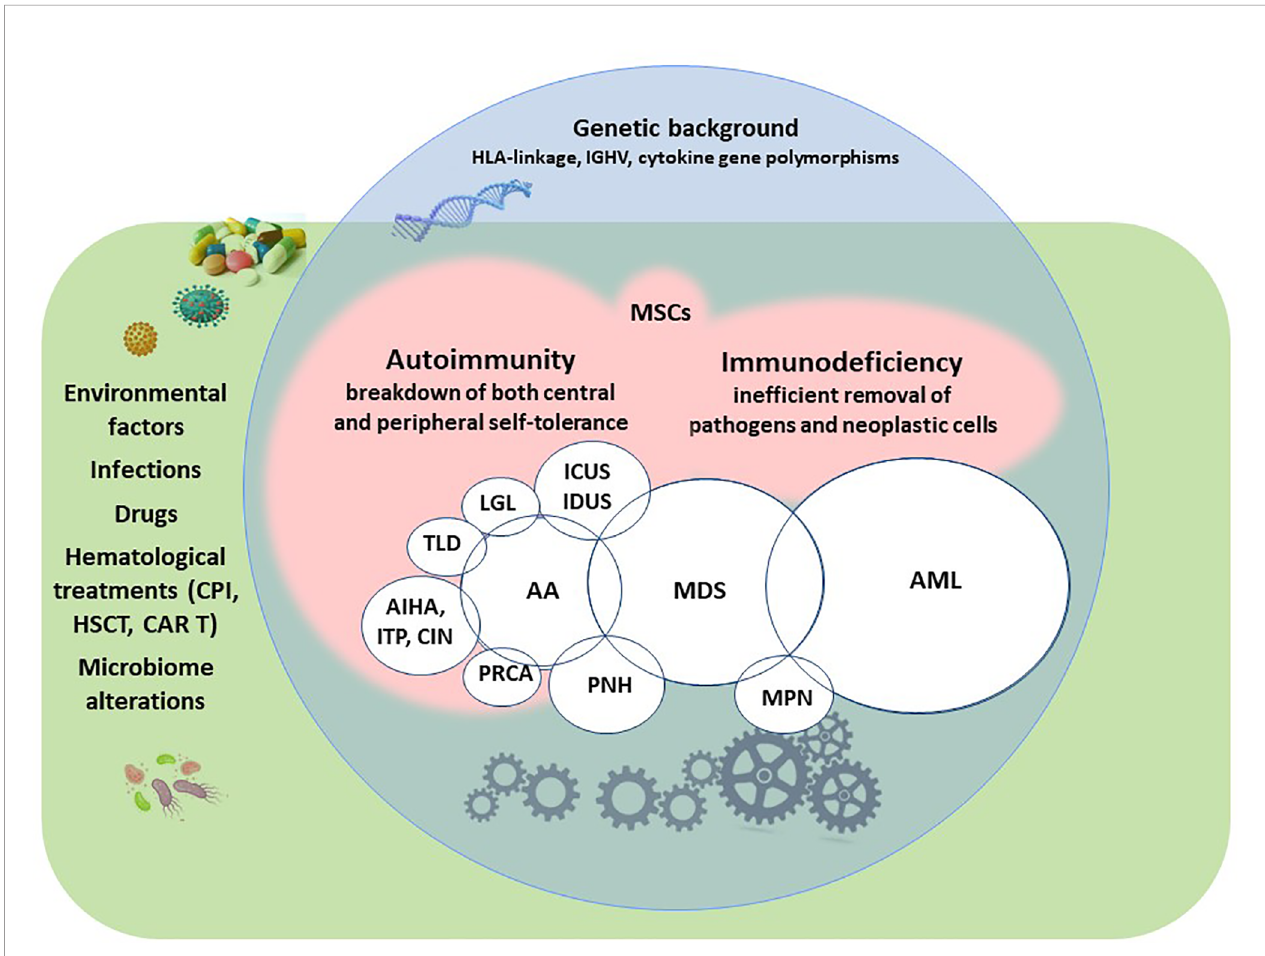
FIGURE 1 | Autoimmunity and immunode fi ciency in myeloid neoplasms and associated conditions. AML, acute myeloid leukemia; MDS, myelodysplastic syndromes; MPN, myeloproliferative neoplasms; AA, aplastic anemia; ICUS, idiopathic cytopenia of undetermined signi fi cance; IDUS, idiopathic dysplasia of undetermined signi fi cance; PNH, paroxysmal nocturnal hemoglobinuria; PRCA, pure red cell aplasia; AIHA, autoimmune hemolytic anemia; ITP, immune thrombocytopenia, CIN, chronic idiopathic neutropenia; TLD, telomeres diseases; LGL, large granular lymphocyte lymphoproliferative syndromes; CPI, checkpoint inhibitors; HSCT, hematopoietic stem cell transplantation; CAR T, chimeric antigen receptor T-cells; MSCs, mesenchymal stem